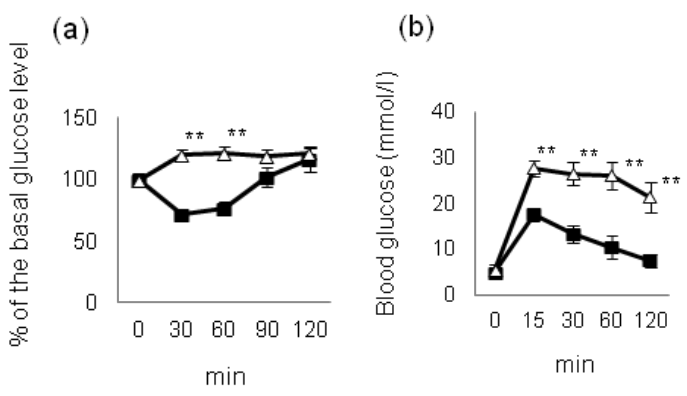
Figure 2. Insulin tolerance test ( a ) and oral glucose tolerance test; ( b ) in the WT and Irs1 −/− mice fed a HF diet for 30 weeks (WT: filled squares; Irs1 −/− : open triangles). Values are the means ± S.E. ** p < 0.01